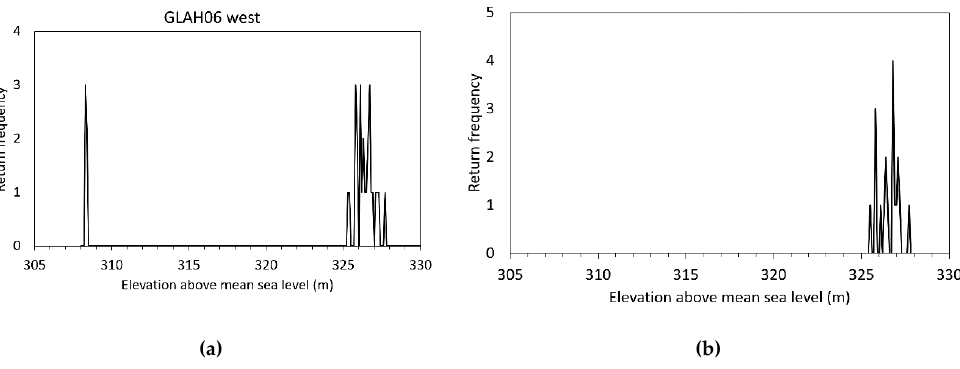
Figure 5. ICESat GLAS west region returns; ( a ) GLAH06, ( b ) GLAH14.